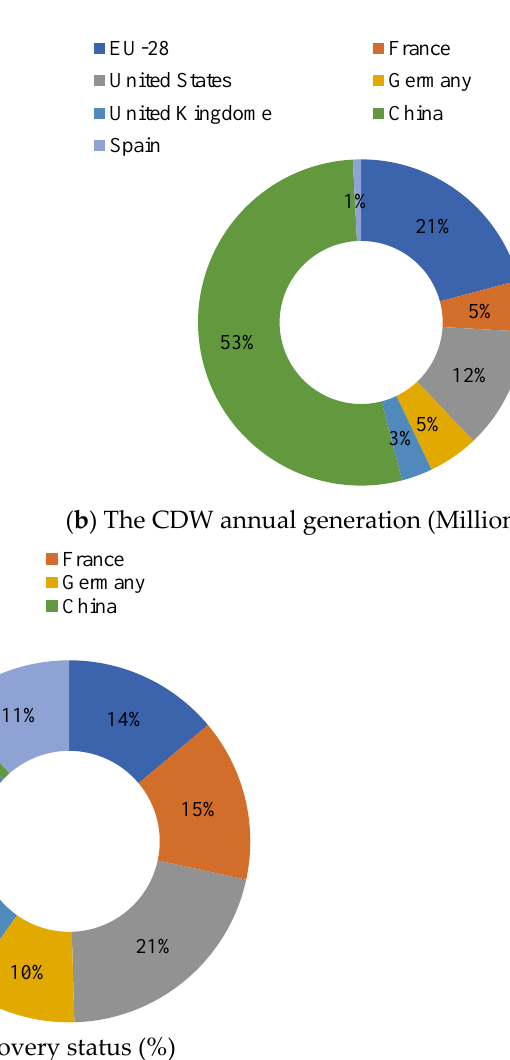
Figure 2. Demolition of constructions and recycling of waste globally.